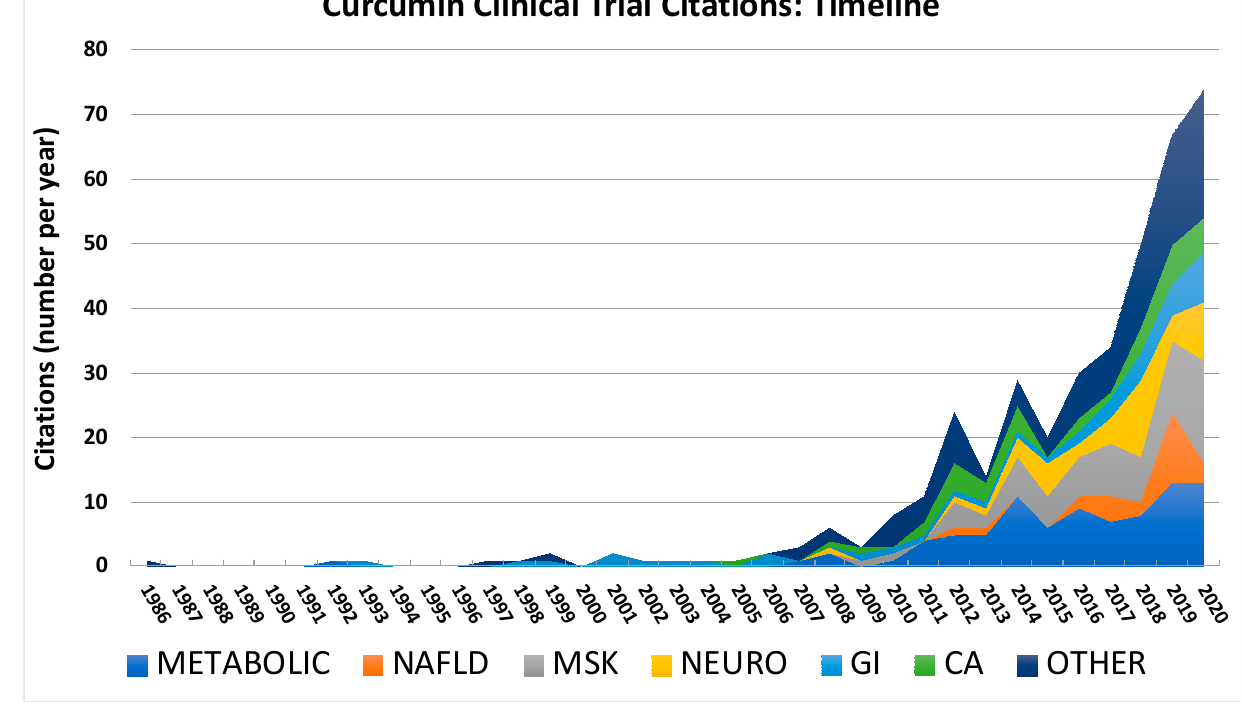
Figure 4. Publication timeline for curcumin clinical trials. Citations per year are presented in stacked plots to demonstrate secular trends for the five most common categories, including metabolic (with NAFLD graphed separately), musculoskeletal (MSK), neuropsychiatric (NEURO), and gastrointes- tinal (GI, excluding NAFLD) disorders or cancer [CA]. All other diseases (OTHER) are graphed as a group.